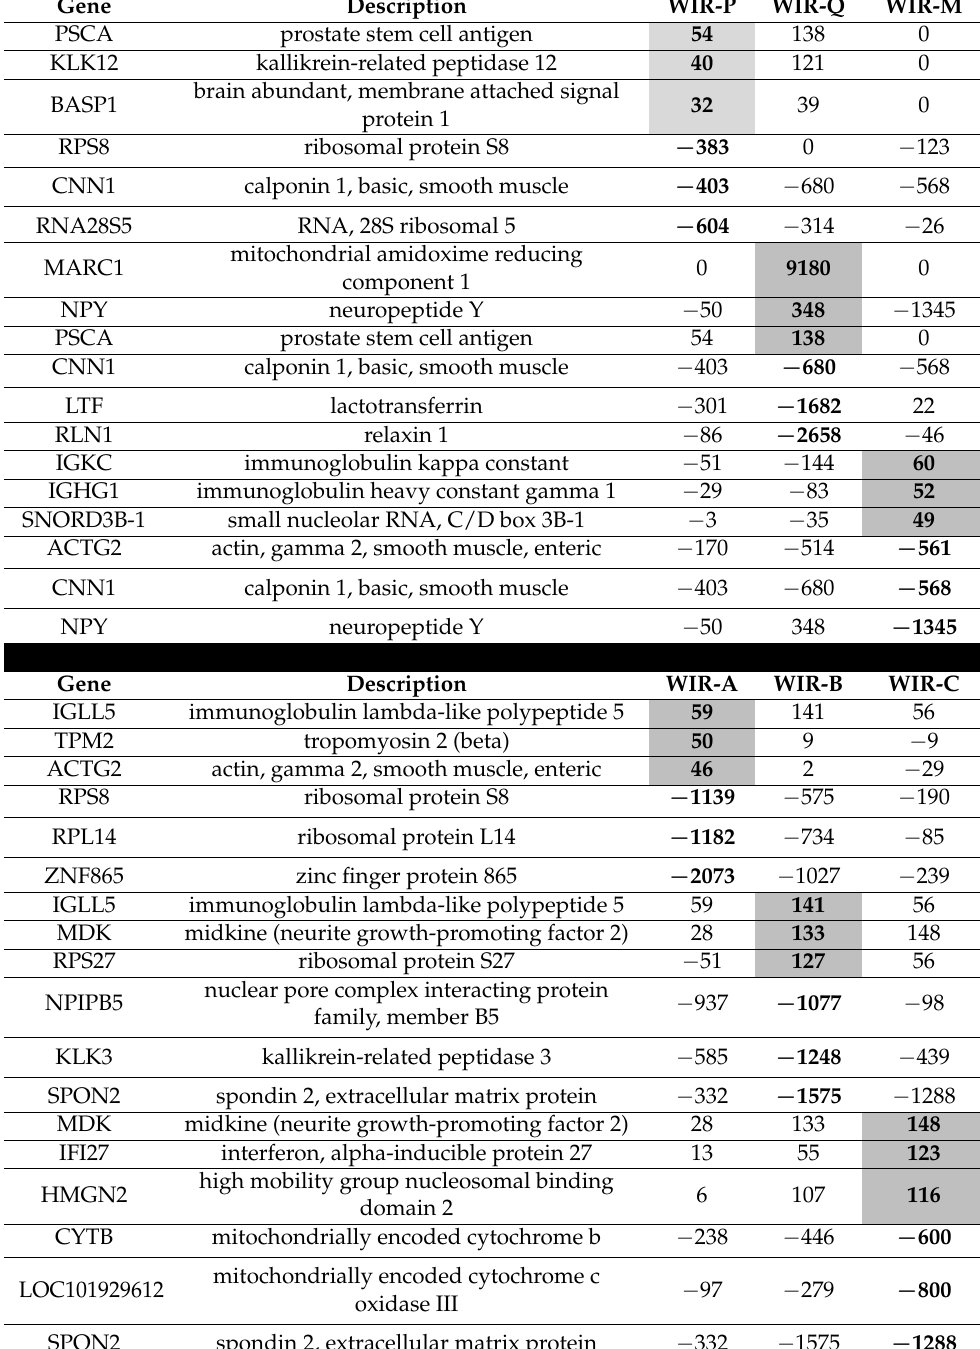
Table 3. Three genes with the largest positive and negative contributions to the transcriptomic alterations in the cancer nodules of the “PQMZ” and “ABCN” patients.